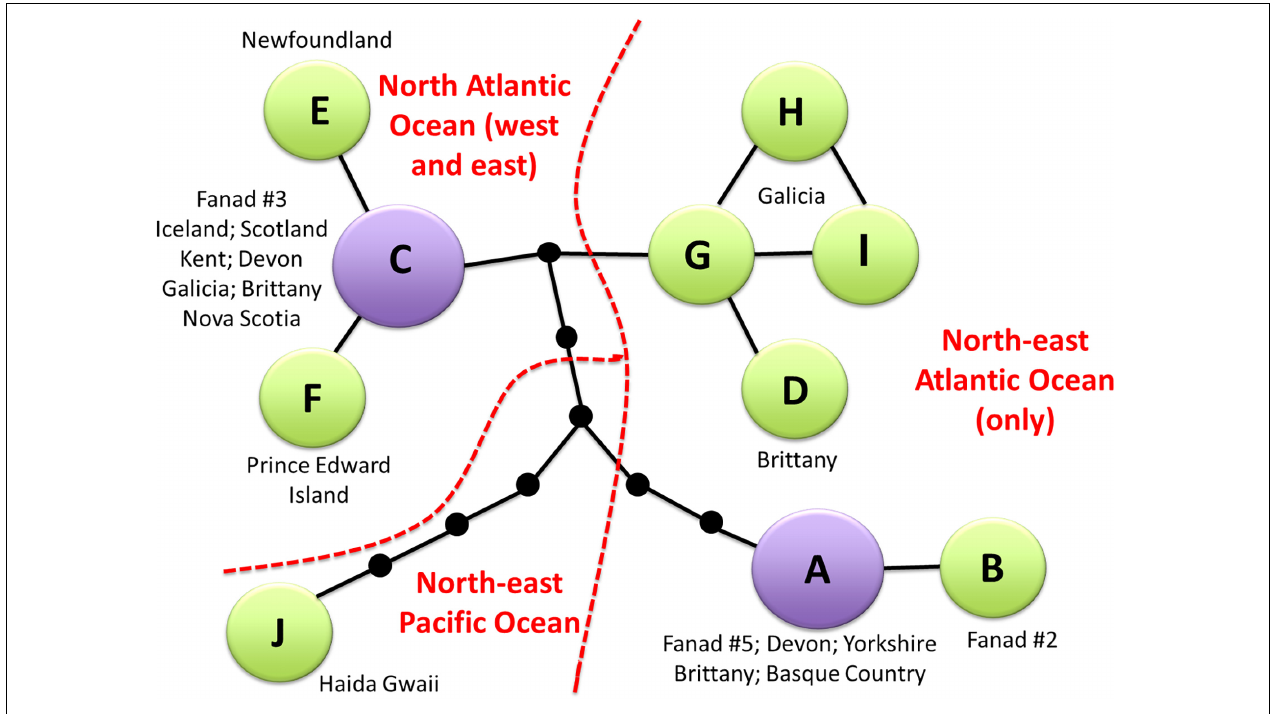
FIGURE 3 | Parsimony network for cox 1 sequences of Corallina officinalis from Fanad sampling site and sequences from GenBank generated in TCS. The compressed alignment is shown in Supplementary Material 2 . Relationships between haplotypes are depicted with black lines and small black dots indicate missing haplotypes. Haplotypes A and C (purple) are the two commonest and most widespread. An overview of the biogeographical distribution is presented in